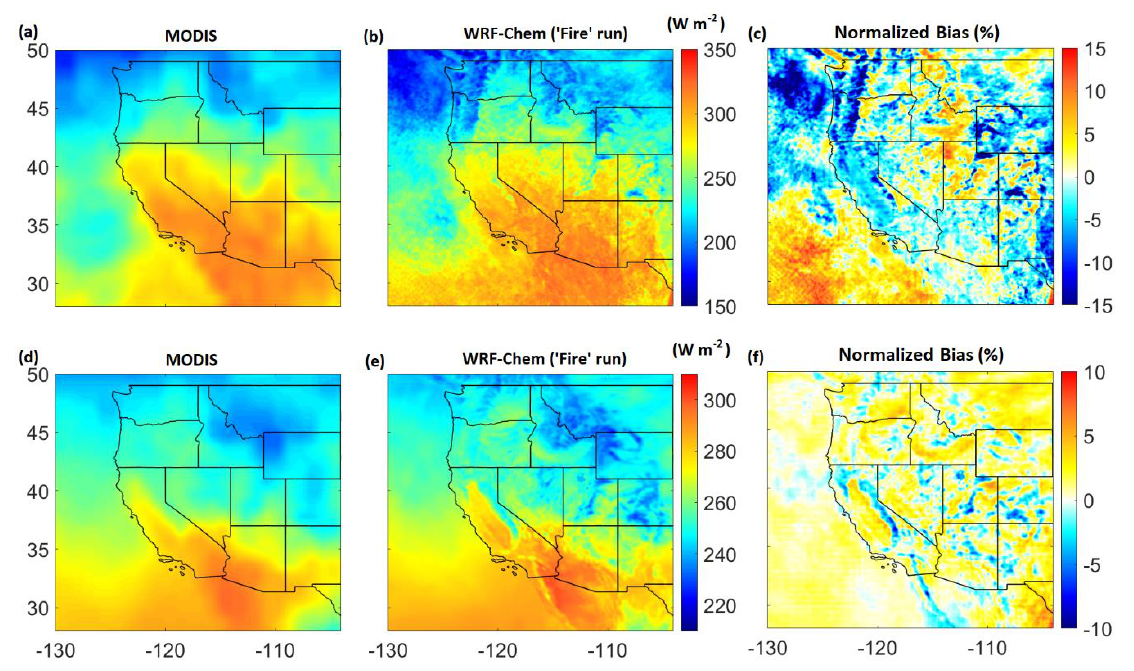
Figure 4. Shortwave downward surface radiation (in W m −2 ) ( a ) for MODIS, ( b ) for WRF-Chem model (‘Fire’ run) and ( c ) Normalized bias (%) between model and MODIS with respect to MODIS. Additionally shown is outgoing longwave radiation (OLR) at top of the atmosphere (TOA) (in W m −2 ) ( d ) for MODIS, ( e ) for WRF-Chem model (‘Fire’ run) and ( f ) Normalized bias (%) between model and MODIS with respect to MODIS.